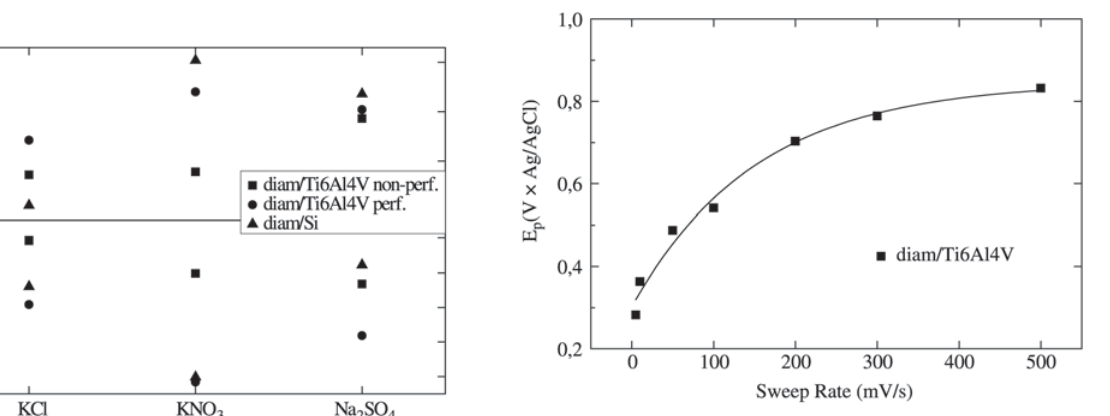
Figure 7. ∆ Ep as a function of sweep rate in 1 mM Ferrocyanide 0,1 M KCl for perforated electrode.